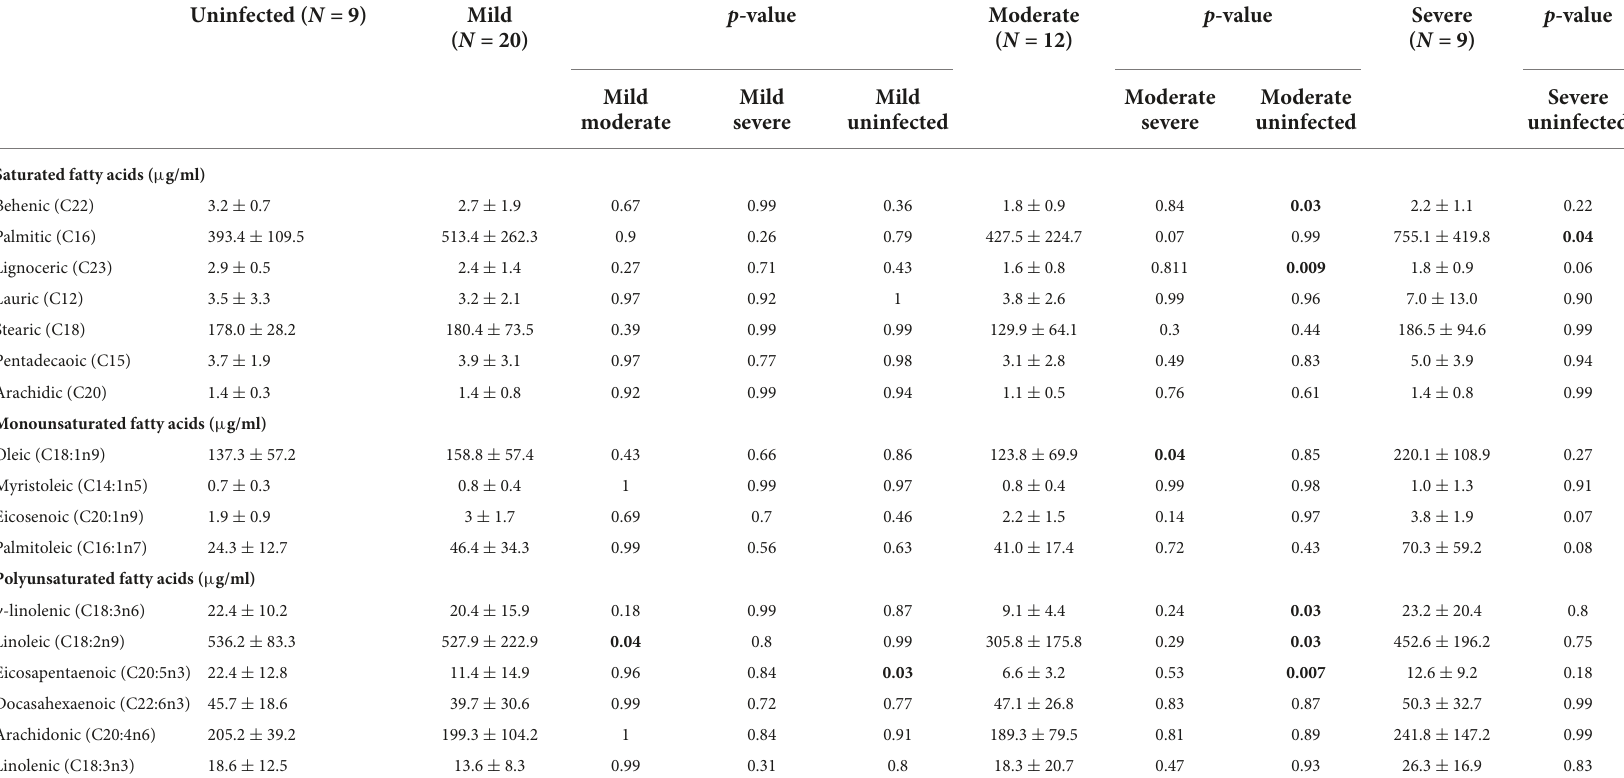
TABLE 2 Baseline fatty acid profile in plasma for mild, moderate, and severe COVID-19 disease severity compared to uninfected adults. p -value Moderate p -value Severe p -value Uninfected ( N = 9) Mild ( N = 20) ( N = 12) ( N = 9) Mild